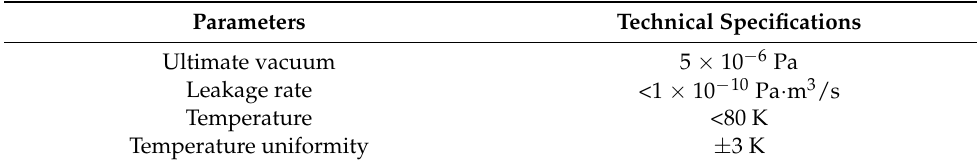
Figure 11. Schematic diagram of a vacuum tank with a heat sink (top view). Table 6. Main technical parameters of the vacuum tank with a heat sink.